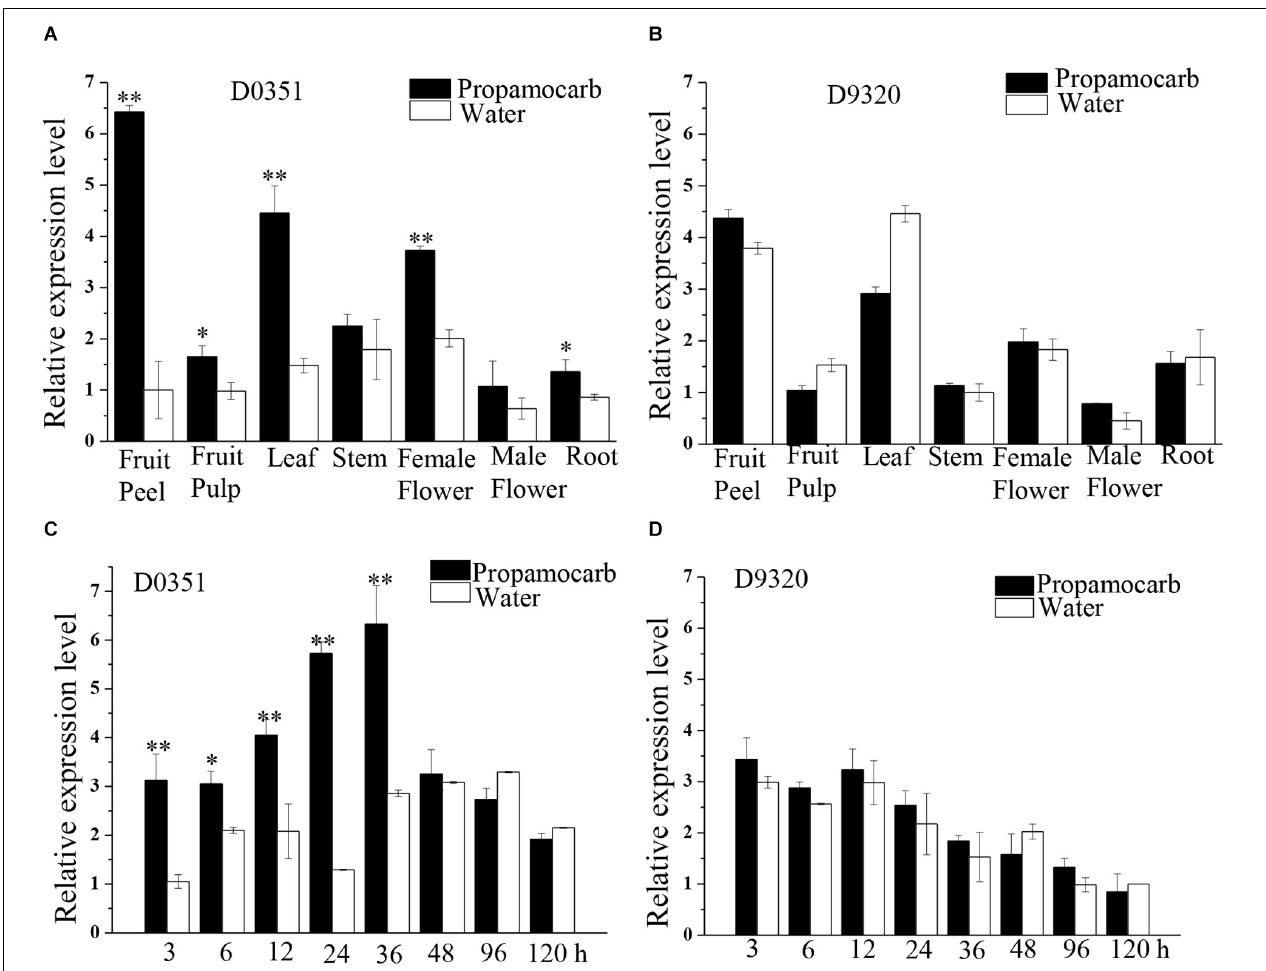
FIGURE 3 | Expression patterns of CsHMGB in cucumbers. (A) CsHMGB levels in various tissues of “D0351” plants under propamocarb stress at 2days after application. (B) CsHMGB levels in different tissues of “D9320” plants under propamocarb stress at 2 days. (C) Time course of CsHMGB levels in fruit peels following propamocarb stress in “D0351” plants. (D) Time course of CsHMGB levels in fruit peels following propamocarb stress in “D9320” plants. CsEF1a was used as the reference gene. Significant differences were observed between treatment (* p < 0.05 and ** p < 0.01) by Student’s t -test.